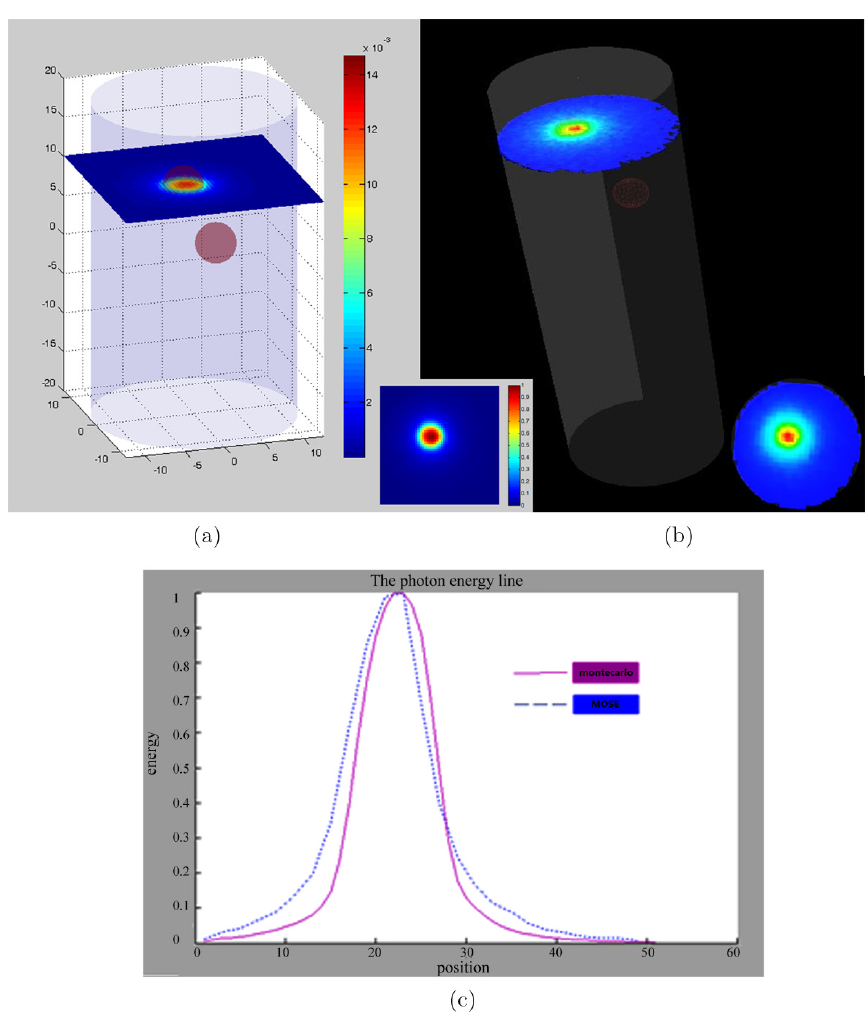
Fig. 4. Comparison between ISEFMT and MOSE visually and quantitatively through the photon energy trend line. (a) The simulation by ISEFMT, (b) the simulation by MOSE and (c) comparison between ISEFMT and MOSE.